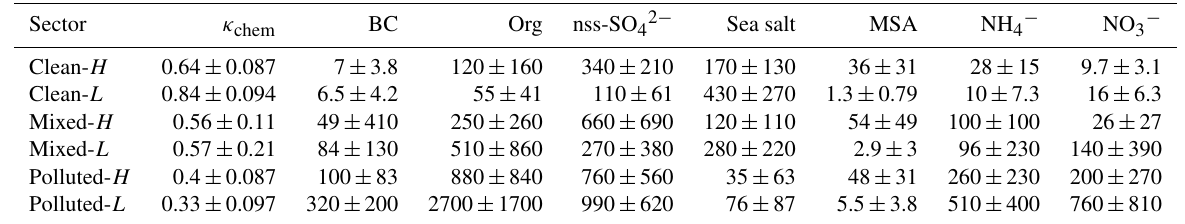
Table 4. The mass concentration (ngm − 3 ) of chemical composition and κ chem in each type of air mass (arithmetic mean ± standard deviation).